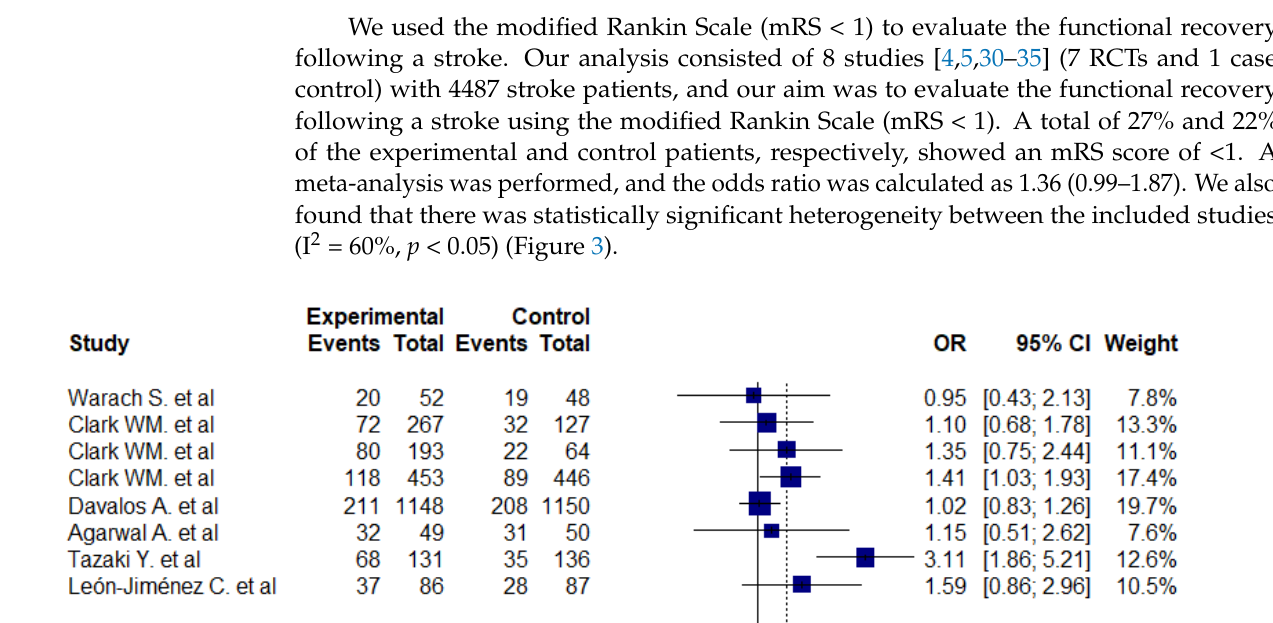
Figure 2. The forest plot of treatment e ff ect of citicoline on neurological function (using NIHSS < 1).